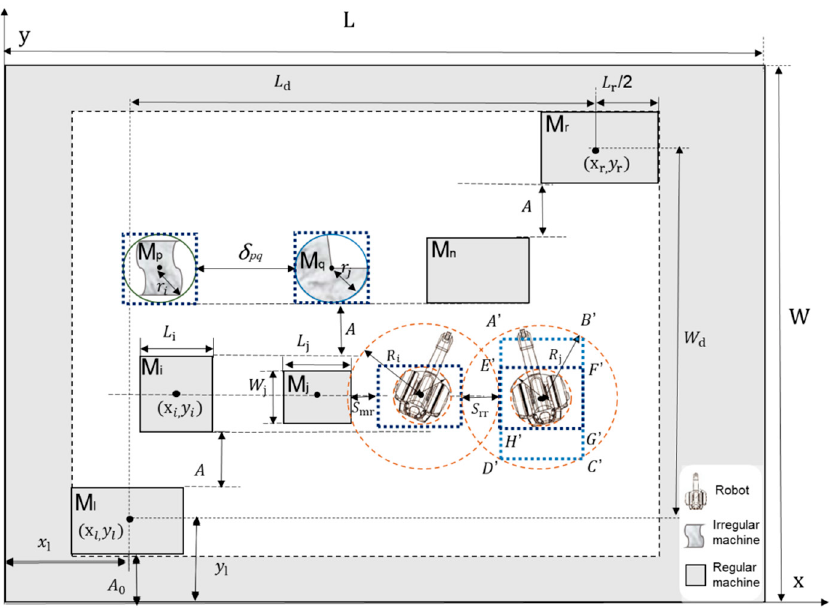
Figure 1. Schematic of the assembly line layout.